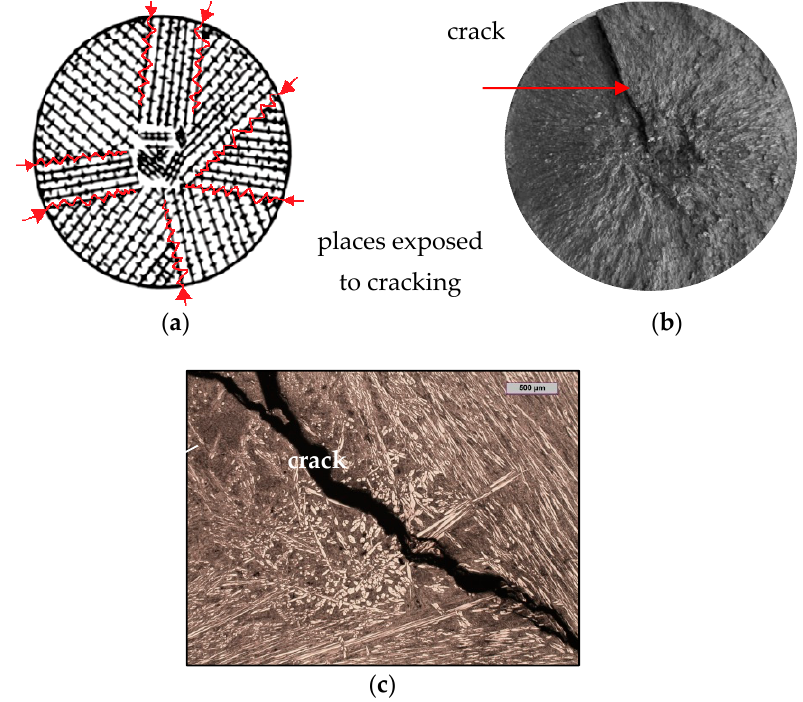
Figure 1. Hot crack propagation in white cast iron with directional of coarse-grained structure: ( a ) scheme of crack formation at grain boundaries [1,2]; ( b ) fracture of chromium cast iron casting with visible crack; ( c ) microstructure of chromium cast iron casting with visible crack (own research).